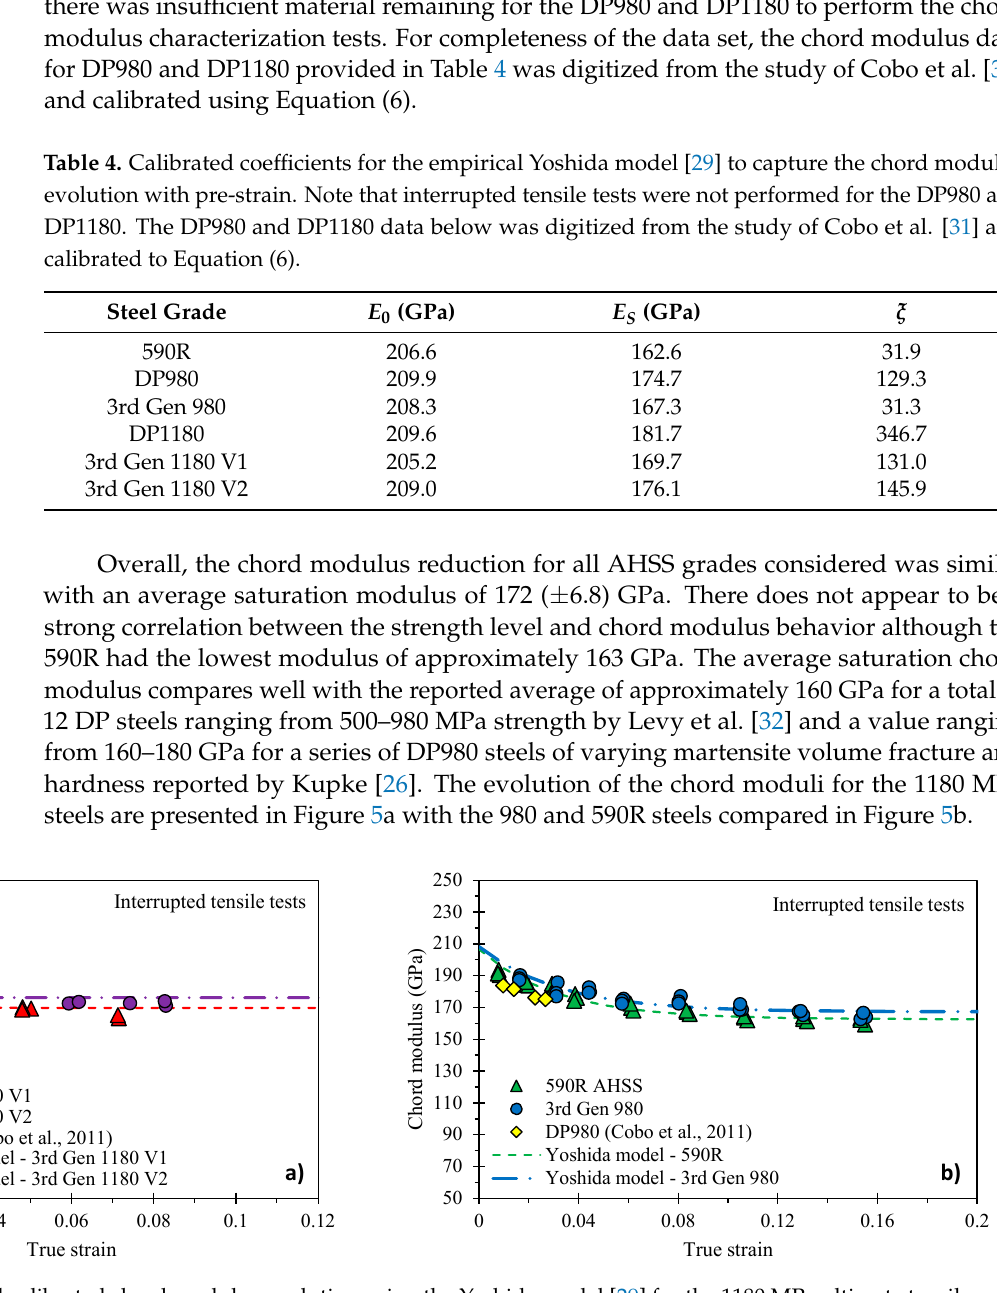
Figure 5. Measured and calibrated chord modulus evolution using the Yoshida model [29] for the 1180 MPa ultimate tensile strength steels ( a ) and the 590 MPa and 980 MPa strength steels ( b ). Note that the data for the DP980 and the DP1180 was digitized from the study of Cobo et al. [31].